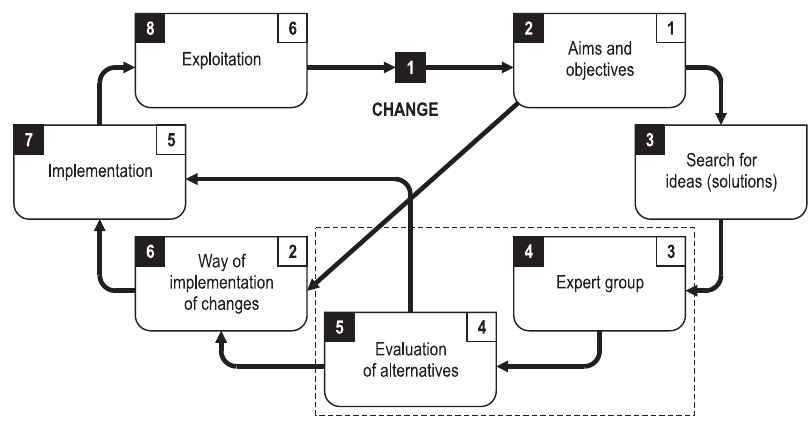
Fig. 3. Change management solution search algorithm (Elskytė